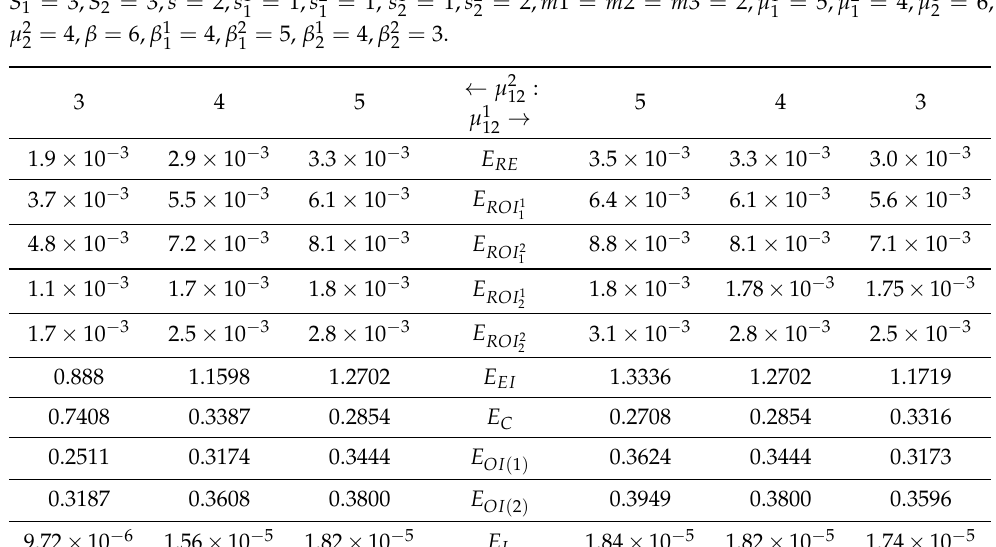
= 5) and µ 2 (fix µ 2 12 12